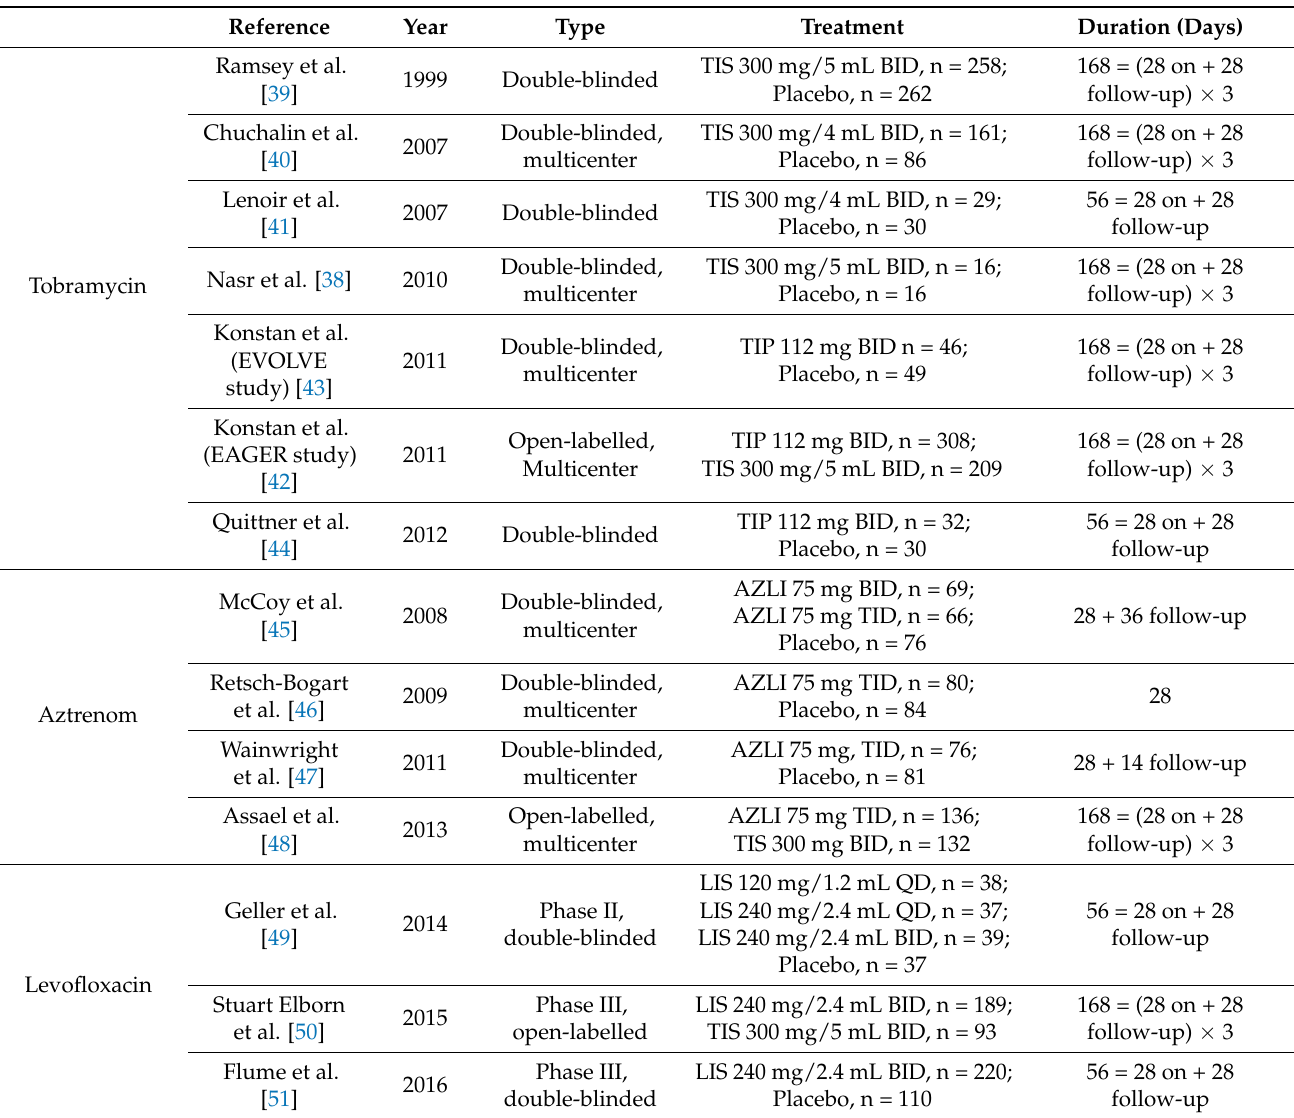
Table 2. Randomized studies on inhaled antibiotics in treating P. aerugonisa chronic pulmonary infection in CF